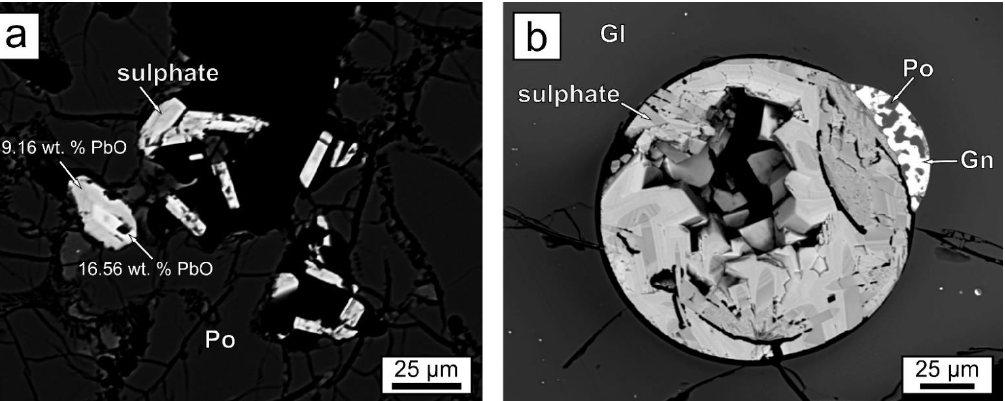
Figure 7. Examples of sulphates, sulphides, and metals in the slags. Photos in BSE. ( a ) zonal sulphates inside sulphidic inclusion (JS9); ( b ) sulphate as an infilling of pore bordering with galena (Gn) dominated by small sulphidic inclusion (PL5). Po – pyrrhotite, Gl – glass. Table 6. Representative compositions of sulphates. The apfu values were calculated on the basis of 4 oxygens. b.d. — below the detection limit.